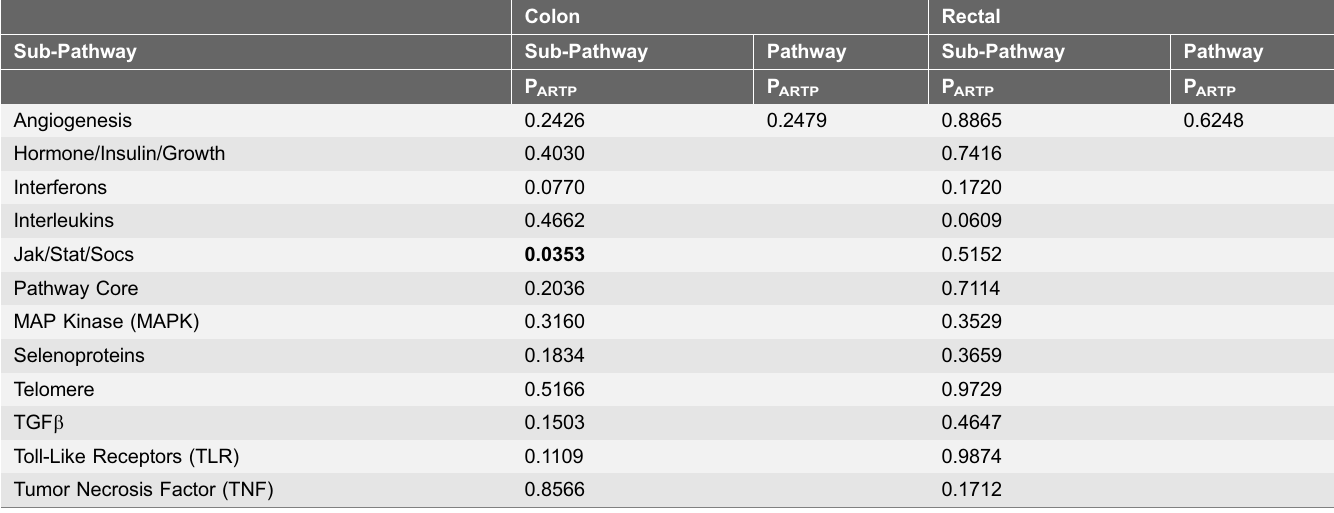
Table 2. Overall pathway P ARTP1